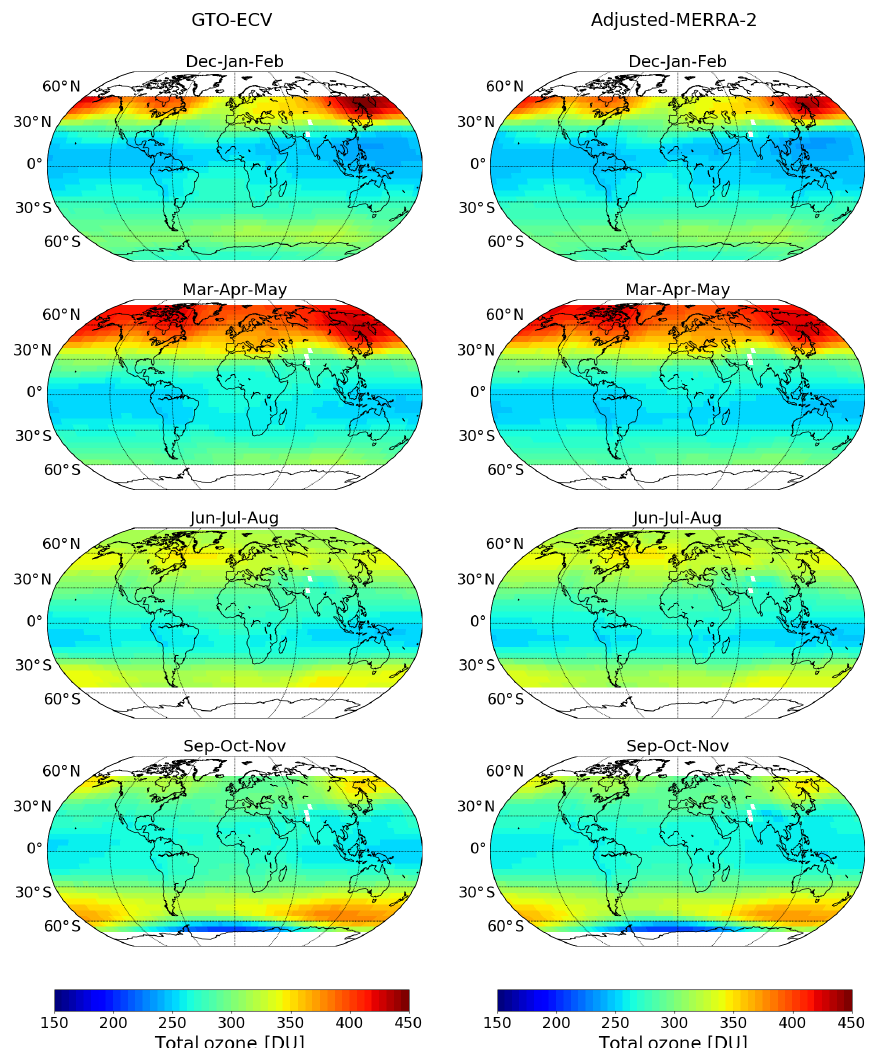
Figure 4. Seasonal mean total ozone columns for GTO-ECV (left column) and adjusted MERRA-2 (right column). From top to bottom: